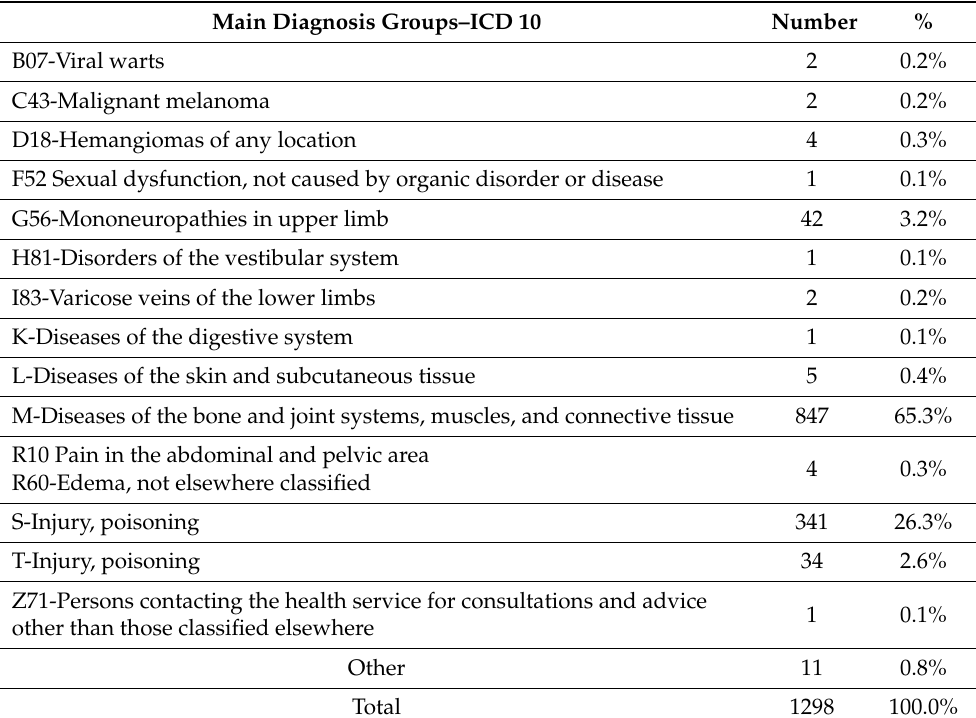
Table 1. The table shows the distribution of general and musculoskeletal diseases, disorders, and injuries diagnosed according to the ICD-10 chapters during all TCs.